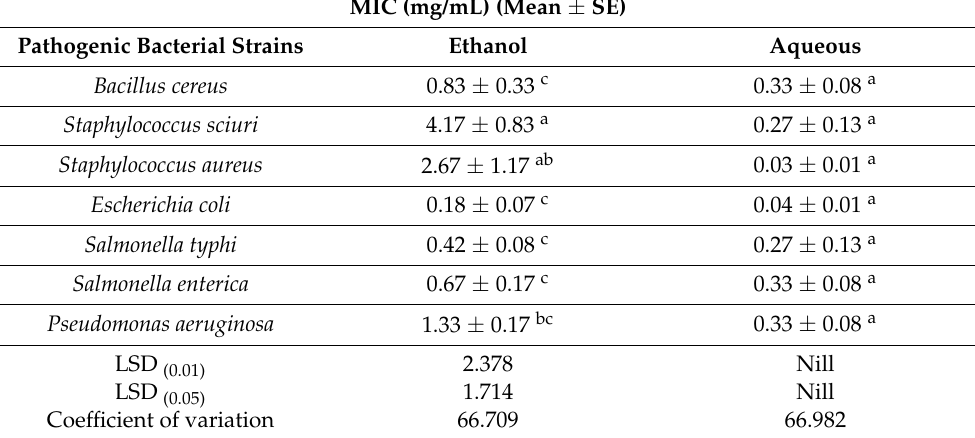
Table 6. The minimum inhibitory concentration of different Moringa extracts against bacterial strains. Moringa Ethanolic and Aqueous Extracts and Bacterial Strains Pathogenic Bacterial Strains